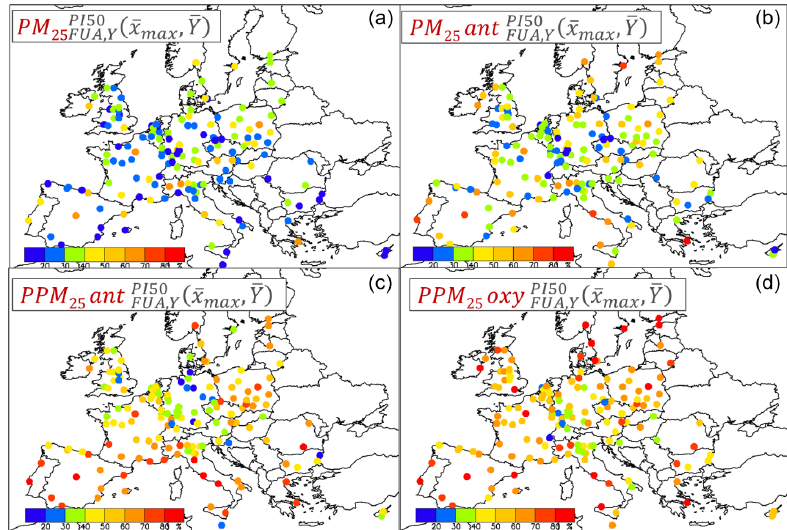
Figure 2. SHERPA results for 150 major cities in Europe for the overall PM 2 . 5 concentration (a) , for its anthropogenic fraction (“PM25_ant”; b ), for its anthropogenic primary fraction (“PPM25_ant”; d ), and for its primary fraction originating from the transport and residential sectors (“PPM25_oxy”; c ). For all cities, the source is defined spatially as the FUA over which emissions are reduced over a year ( Y ). The receptor is defined as the city location where the concentration is maximum ( x max ), and the indicator is averaged yearly at the receptor ( Y ). All calculations are made with the same SA methodology, namely potential impacts (PIs) with city emissions reduced by 50% (PI50).